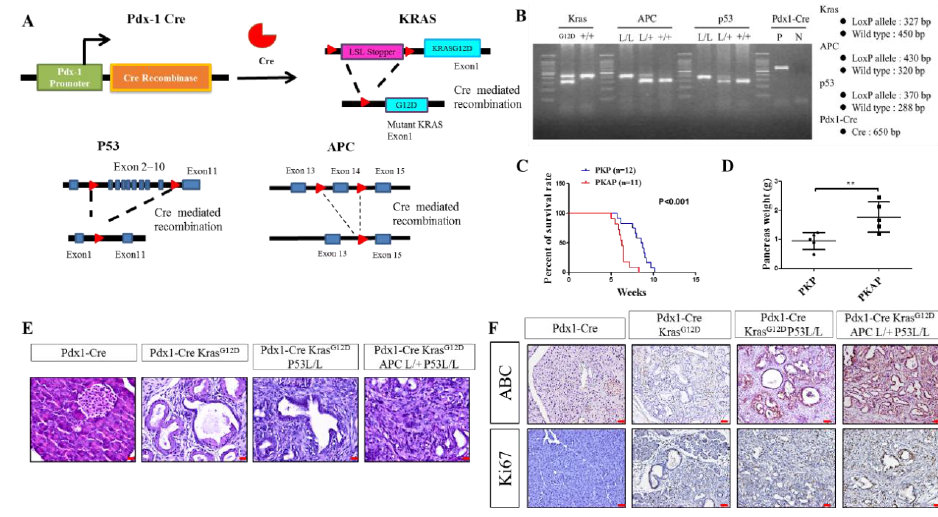
Figure 1. Modeling APC loss in pancreatic ductal adenocarcinoma (PDAC). ( A ) Illustration of strategies to generate Pdx1-Cre, Kras G12D , APC L/L , and p53 L/L (PKAP) mice. ( B ) Specific genotyping polymerase chain reaction (PCR) analysis for the detection of KRAS, APC, p53, and Pdx1-Cre target alleles from the mice tail DNA. ( C ) Kaplan–Meier curves showing the percentage of survival rates for mice of the indicated genotypes. ( D ) Data for mice showing pancreatic weight from the indicated genotypes. ** p -value < 0.01. ( E ) H&E-stained histological sections of pancreatic tissue from different genotypes of mice. ( F ) Immunohistochemical (IHC) staining demonstrated the expression levels of Ki67 and active β-catenin (ABC) in PDAC. The scale bar is 20 μm.